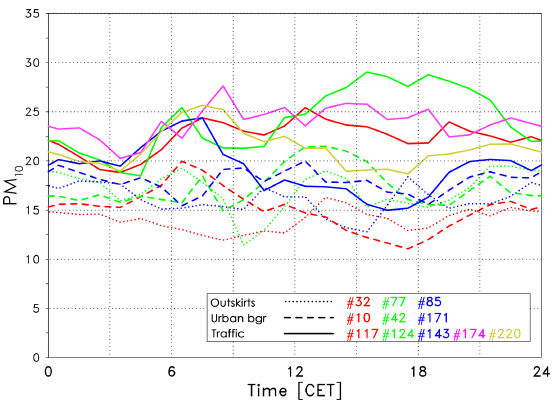
Figure 8. Diurnal cycle of PM 10 in µgm − 3 at 11 BLUME stations, based on medians of measurements on 67 days. The temporal reso- lution is 1h. The locations at the outskirts of Berlin (dotted lines), urban background sites (dashed) and traffic sites (solid) are indi- cated in the legend; see also Table